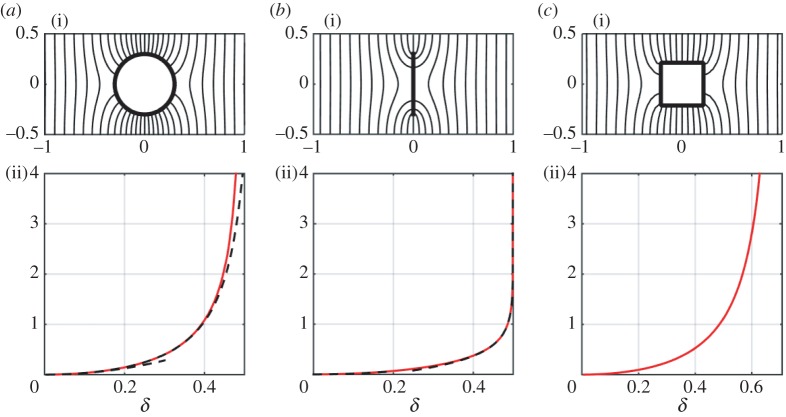
Solutions to the Neumann cell problem (3.25)–(3.28) for (a) disc-shaped wires with radius δ, (b) infinitely thin line segments with length 2δ, and (c) square wires with side length 2δ. Panels (a(i),b(i),c(i)) show contours of Ψ(N,S) for δ=0.3. Panels (a(ii),b(ii),c(ii)) show the constant λ in the far field expansion, as a function of δ. The dashed lines in (a) show the approximations λ∼πδ2 and λ∼πδ2/(1−(πδ)2/3) [22], and in (b) show the behaviour as δ approaches 0 and 12 (here the asymptotic and numerical curves are almost indistinguishable). (Online version in colour.)